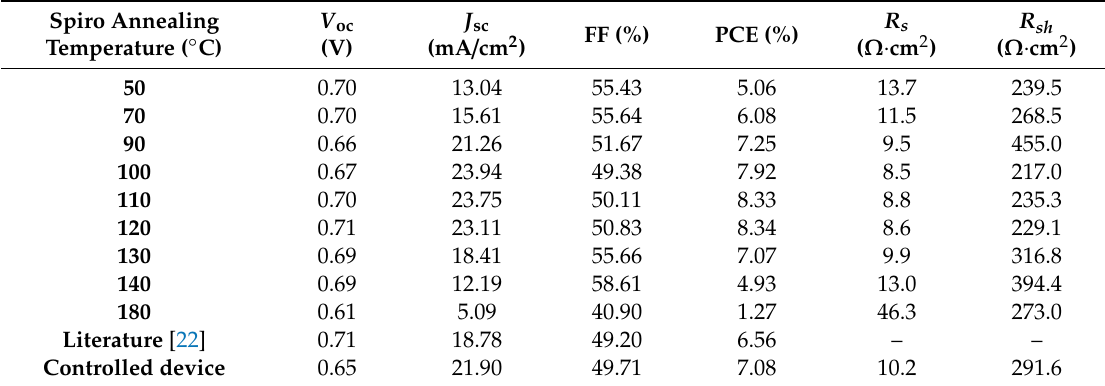
Figure 5. ( a ) The power conversion efficiency (PCE) of NC solar cells with different annealing temperatures; ( b ) the PCE distribution for NC solar cells with the Spiro HTL annealed at 120 °C; ( c ) J–V curves of champion and control devices and ( d ) the corresponding external quantum efficiency (EQE) spectra. Table 1. Summarized performance of NC solar cells with the Spiro HTL annealed at different temperatures (Figure 5a) and Literature [22]. Spiro